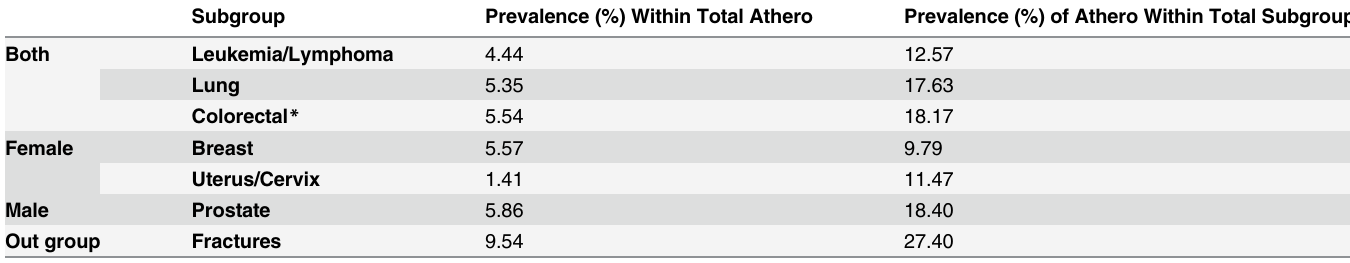
Prevalence (%) within total athero = (# of patients with speci fi c cancer and athero) / (total # of patients with athero) * 100. Prevalence (%) of athero within total subgroup = (# of patient with speci fi c cancer and athero) / (total # of patients with speci fi c cancer) *